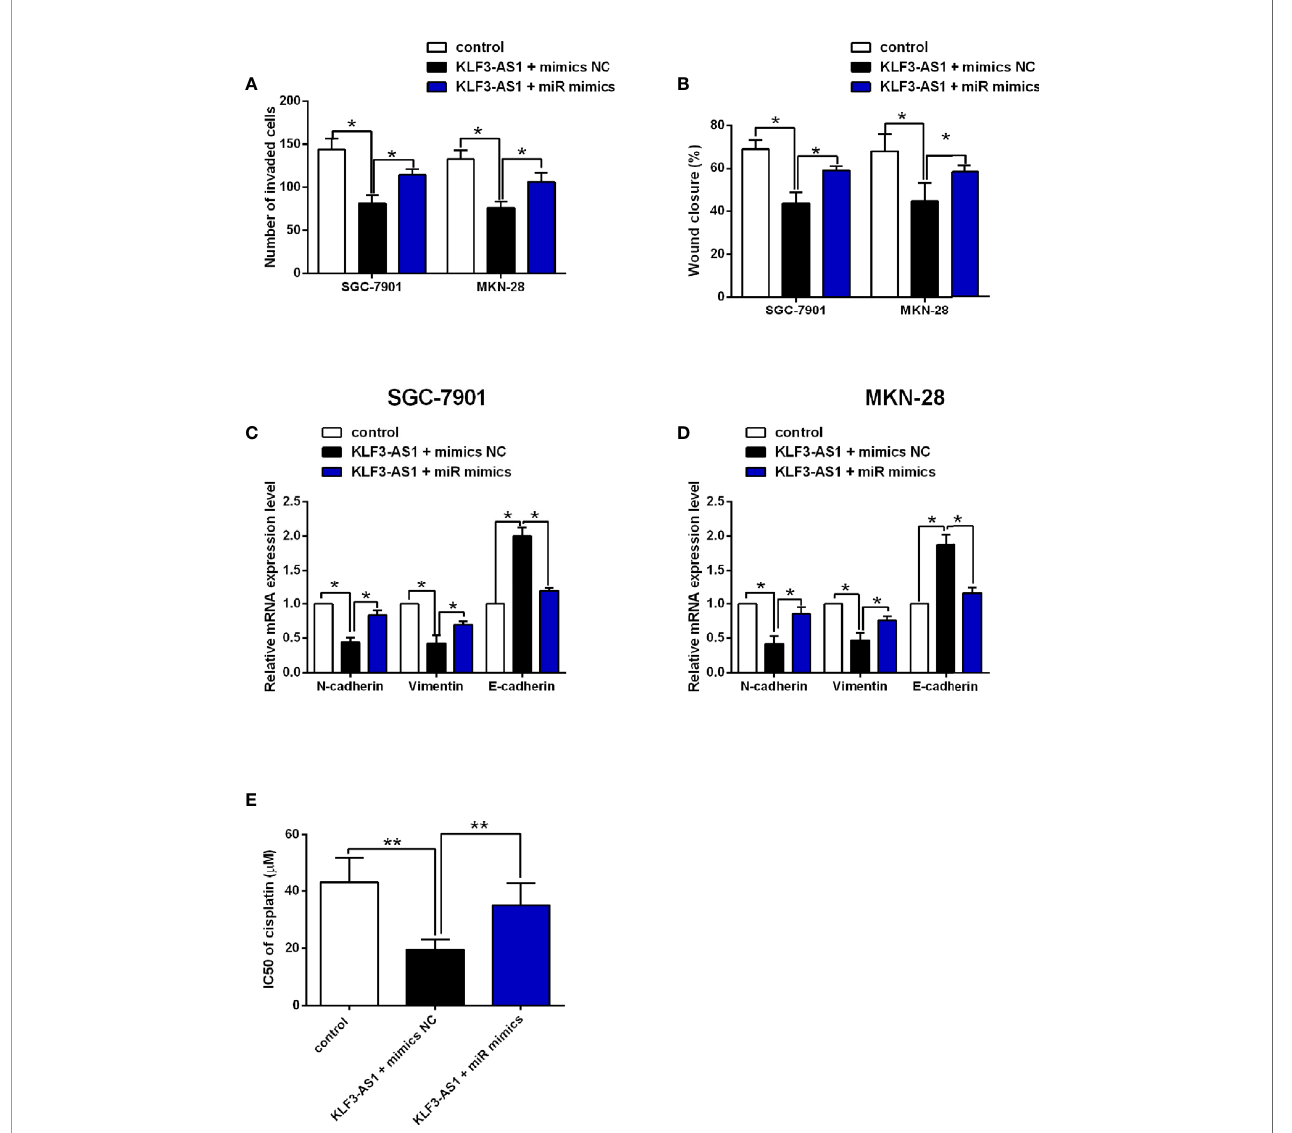
FIGURE 5 | MiR-223 attenuated the effects of KLF3-AS1 on the gastric cell invasion, migration, EMT and chemosensitivity. SGC-7901 and MKN-28 cells were co- transfected with pcDNA3.1 + mimics NC (control group), pcDNA3.1-KLF3-AS1 + mimics NC, or pcDNA3.1-KLF3-AS1 + miR-223 mimics, at 24 h after transfection, (A) cell invasion of SGC-7901 and MKN-28 cells was determined by Transwell invasion assay; (B) cell migration of SGC-7901 and MKN-28 cells was determined by wound healing assay; (C, D) the mRNA expression levels of N-cadherin, vimentin and E-cadherin in SGC-7901 and MKN-28 cells were determined by qRT-PCR. (E) SGC-7901/DDP cells were co-transfected with pcDNA3.1 + mimics NC (control group), pcDNA3.1-KLF3-AS1 + mimics NC, or pcDNA3.1-KLF3-AS1 + miR-223 mimics, the IC50 values of cisplatin in SGC-7901/DDP cells were determined by CCK-8 assay (one-way ANOVA followed by Bonferroni ’ s test). N = 3; *P < 0.05 and **P <